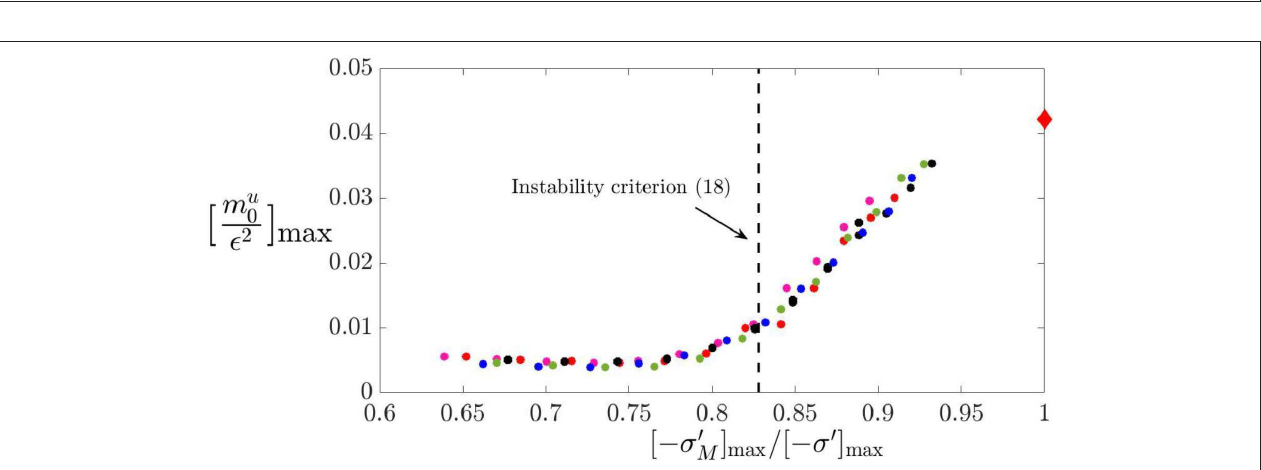
FIGURE 8 | (A) Contour plots of gap g ( x , y ) in the unstable range for β the gap distribution g ( x , y ) from (A) .